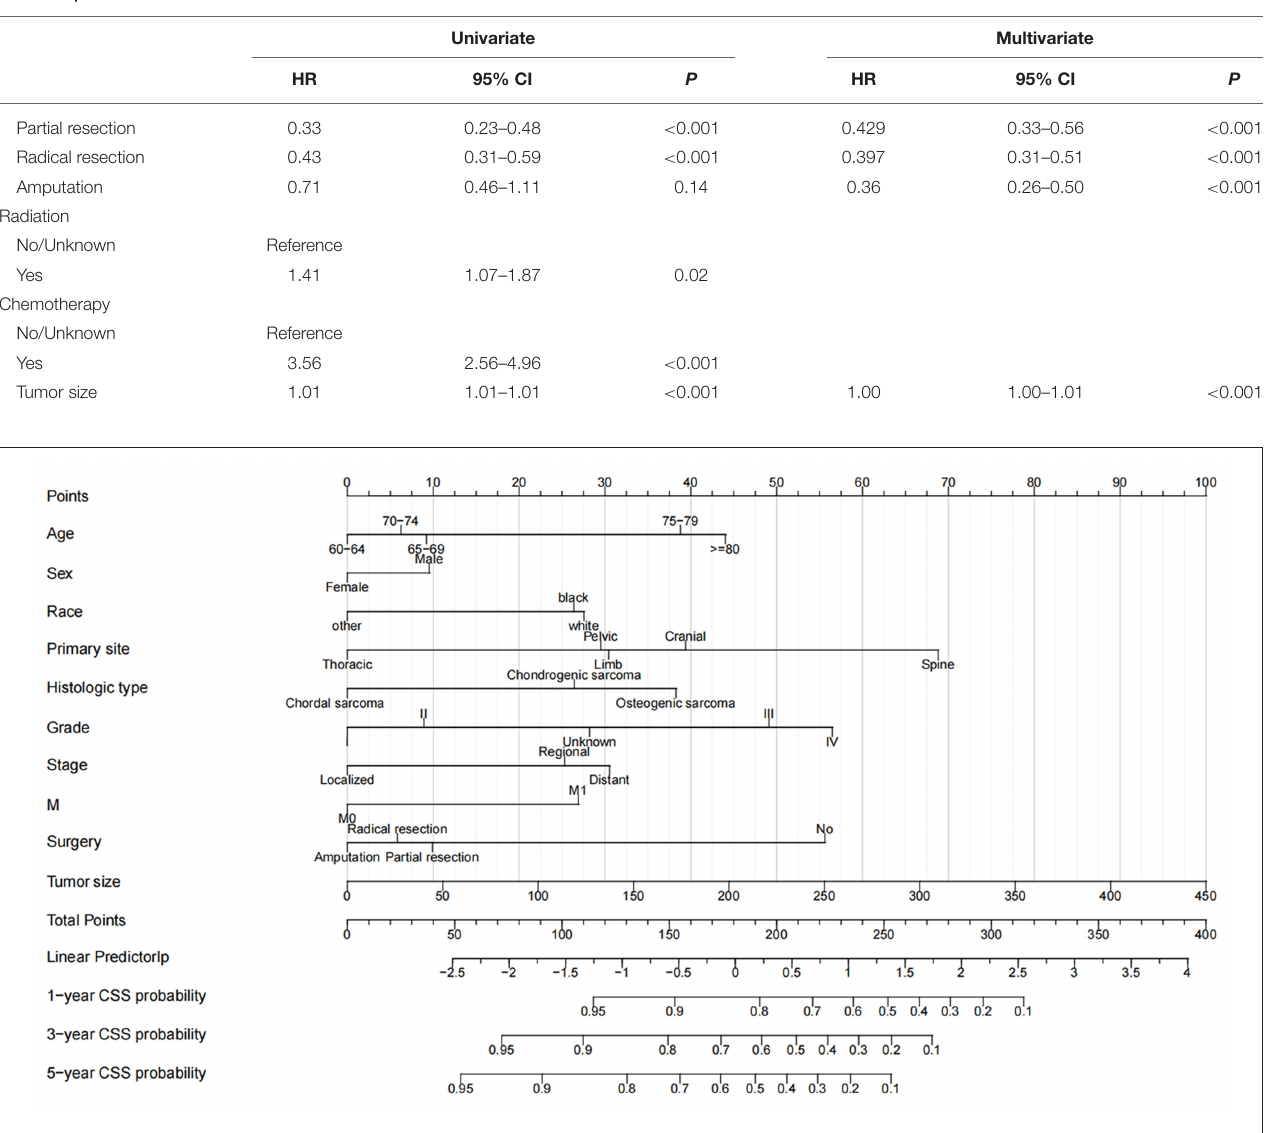
FIGURE 2 | Nomogram for 1-, 3-, and 5-year OS of elderly patients with MBT. The first row of the nomogram is the scoring ruler, rows 2–11 are the variables, and the 12th row is the patient’s total score. 13–16 are the full score corresponding to the patient’s 1-, 3-, and 5- survival